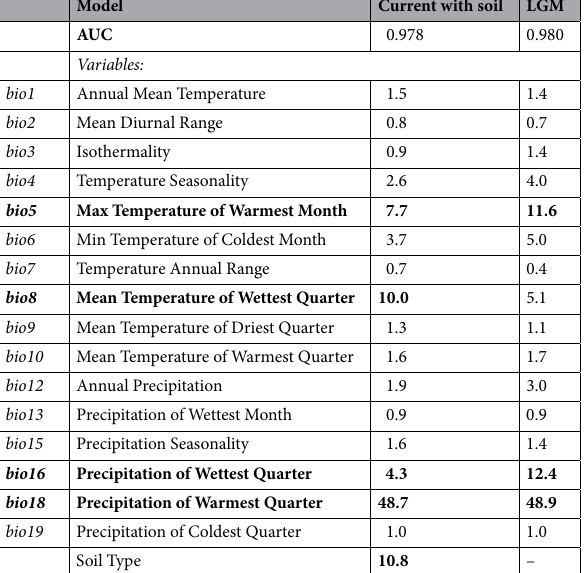
Table 3. Contribution of 19 environmental variables in the tested climate models. Bold values are those parameters that have the highest input into the